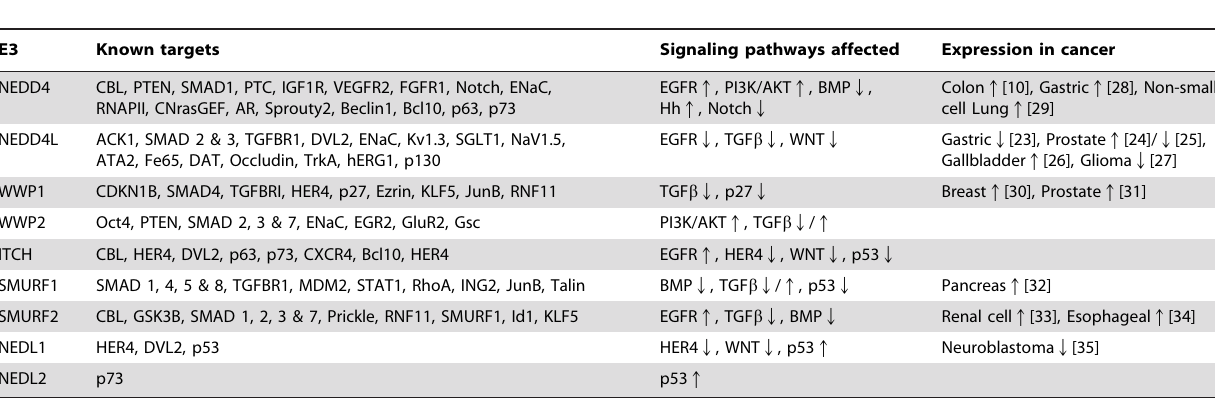
In the ‘‘Signaling pathways affected’’ and ‘‘Expression in cancer’’ columns, Q indicates inhibition and downregulation, respectively, while q indicates activation and upregulation. Patched (PTC), epithelial sodium channel (ENaC), cyclic nucleotide ras GEF (CNrasGEF), androgen receptor (AR), B-cell CLL/lymphoma 10 (Bcl10), potassium voltage-gated channel, shaker-related subfamily, member 3 (Kv1.3), sodium/glucose cotransporter 1 (SGLT1), sodium channel, voltage-gated, type V (NaV1.5), amyloid beta A4 precursor protein-binding family B member 1 (Fe65), dopamine transporter (DAT), inhibitor of growth 2